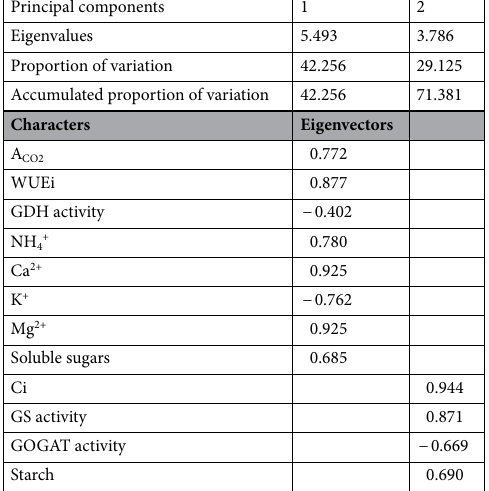
Table 2. Eigenvalues, proportion of variation, accumulated proportion of variation, and eigenvectors associated with the two axes of the